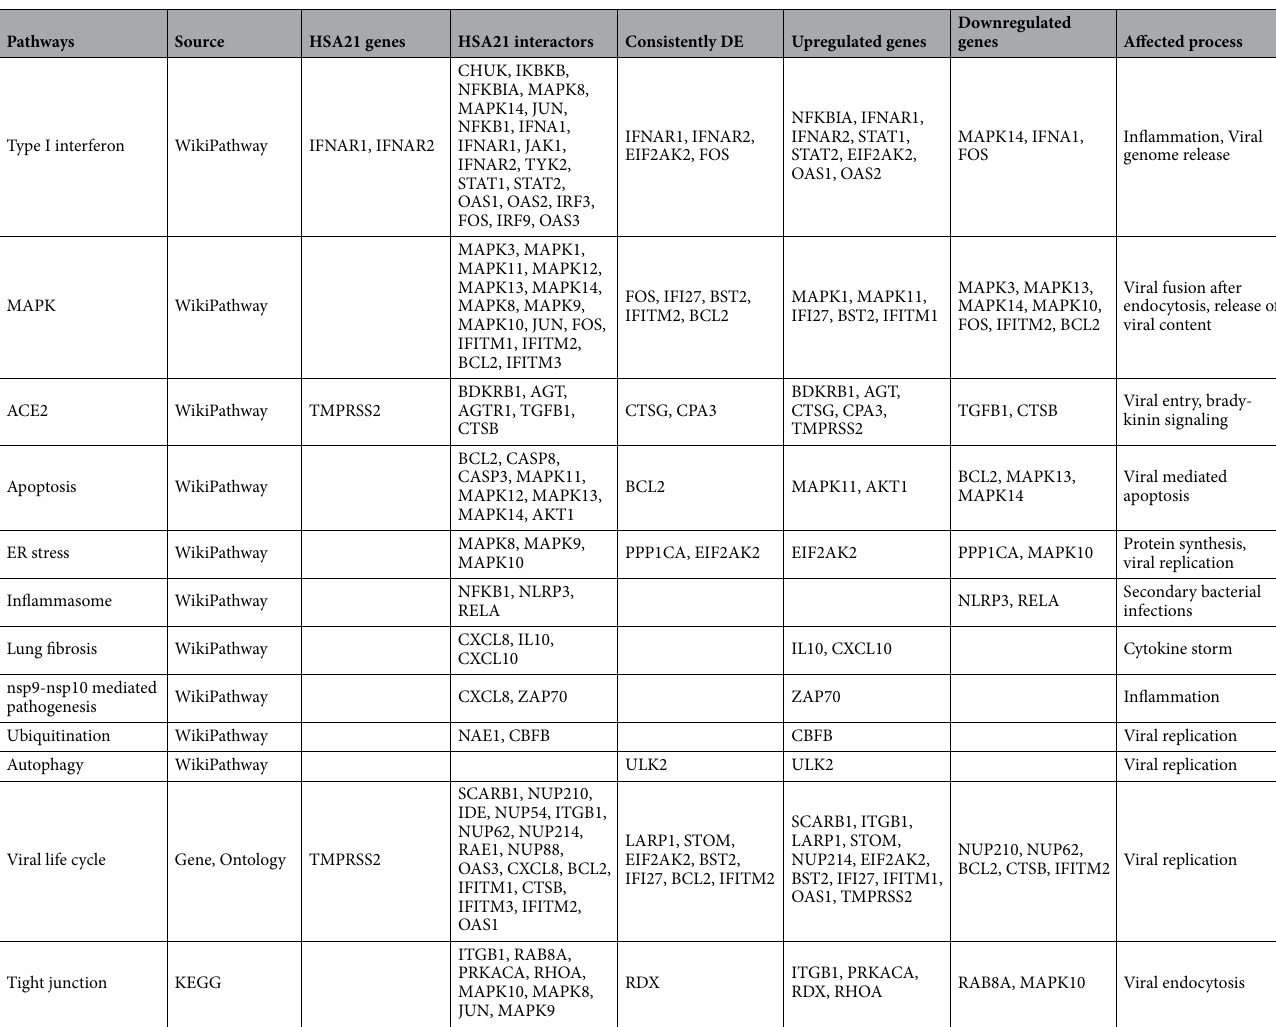
Table 1. COVID19 related pathways affected in